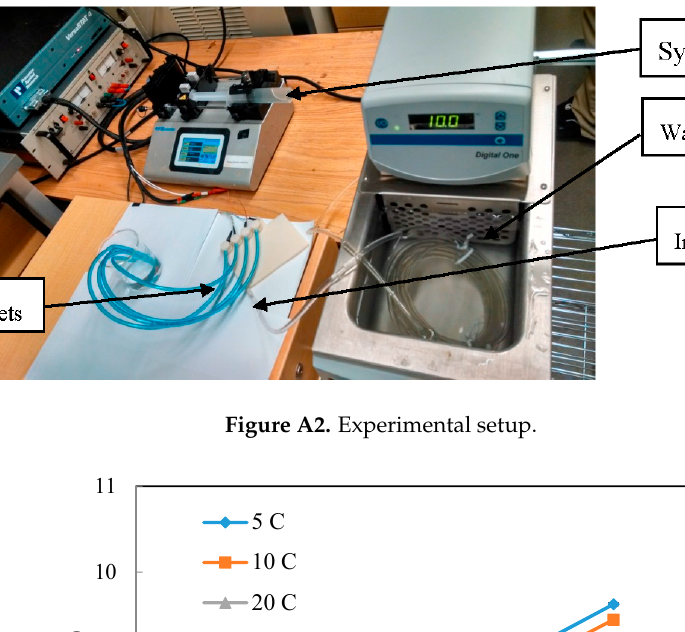
Figure A1. ( a ) Design of the interface; ( b ) Fabrication of the interface using a 3D printer; in this approach, the part was printed on a hop plate and stopped for inserting sensors; ( c ) Dimensions of final 3D print design for reproduction; and ( d ) design of first prototype. Using two polymethyl methacrylate plates with channels machined into it.